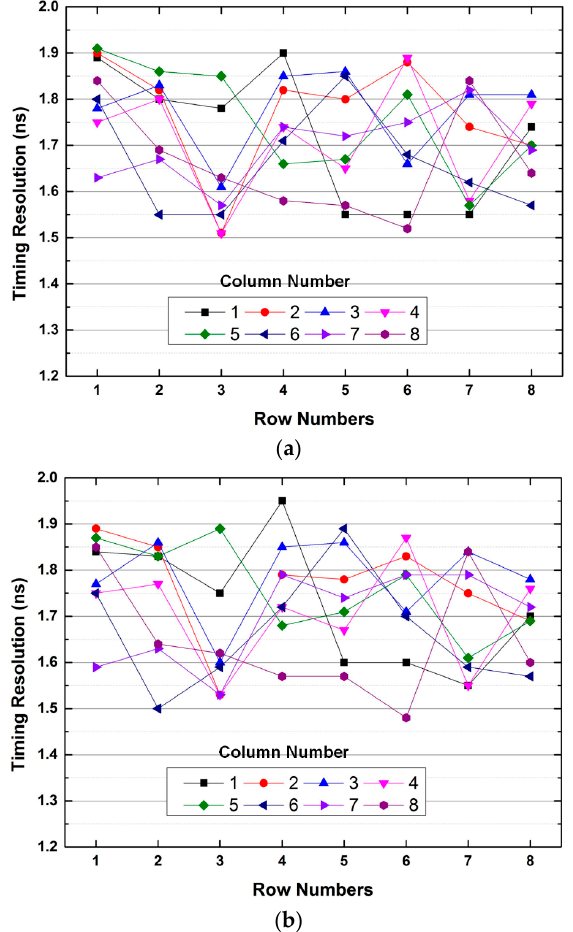
Figure 14. Measured timing resolution ( a ) without and ( b ) with the two-step FSI.